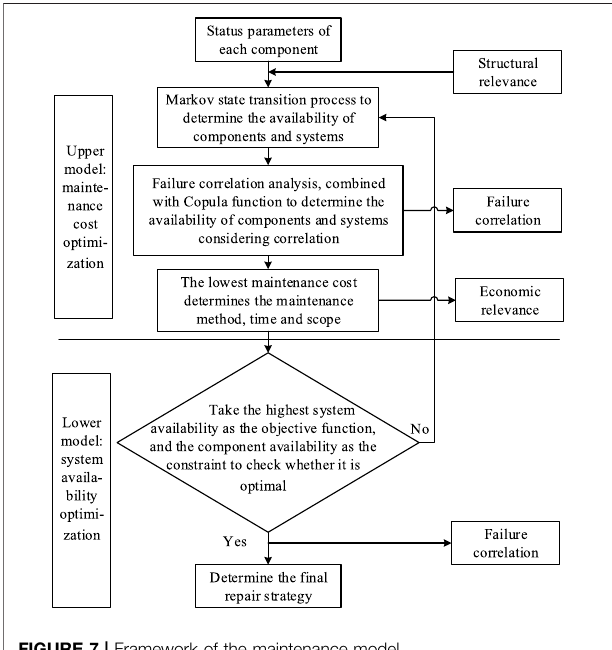
FIGURE 7 | Framework of the maintenance